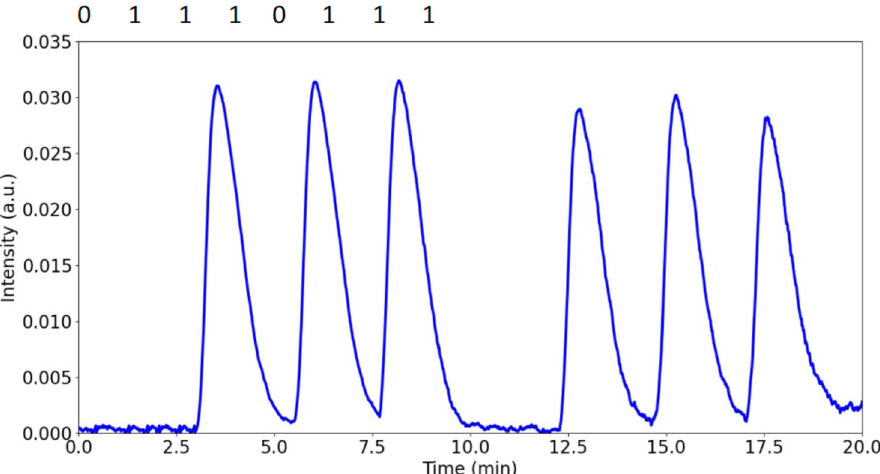
Figure 10. Experimental bit sequence representing the letter (cid:48) w (cid:48) in ASCII